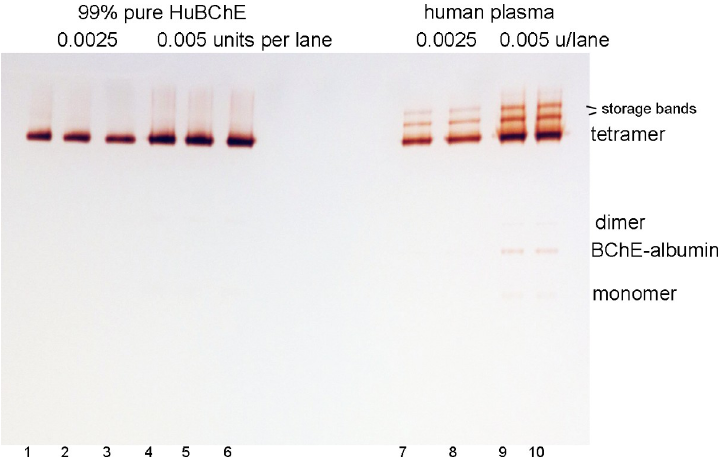
Fig 10. Pure HuBChE from Cohn fraction migrates to the same position as BChE tetramers in human plasma on a nondenaturing gel stained for BChE activity.